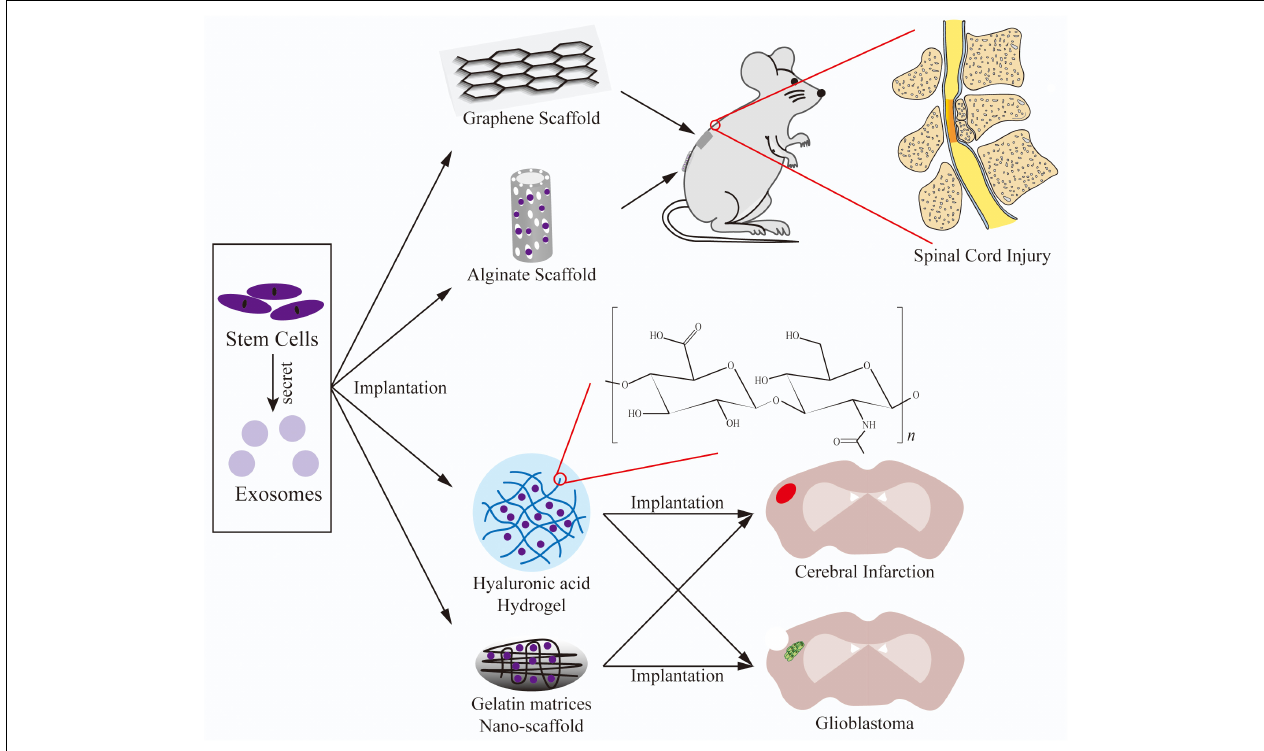
FIGURE 3 | The application of 3D scaffolds combined with SCs/exosomes implanted into models of SCI, cerebral infarction, and glioblastoma